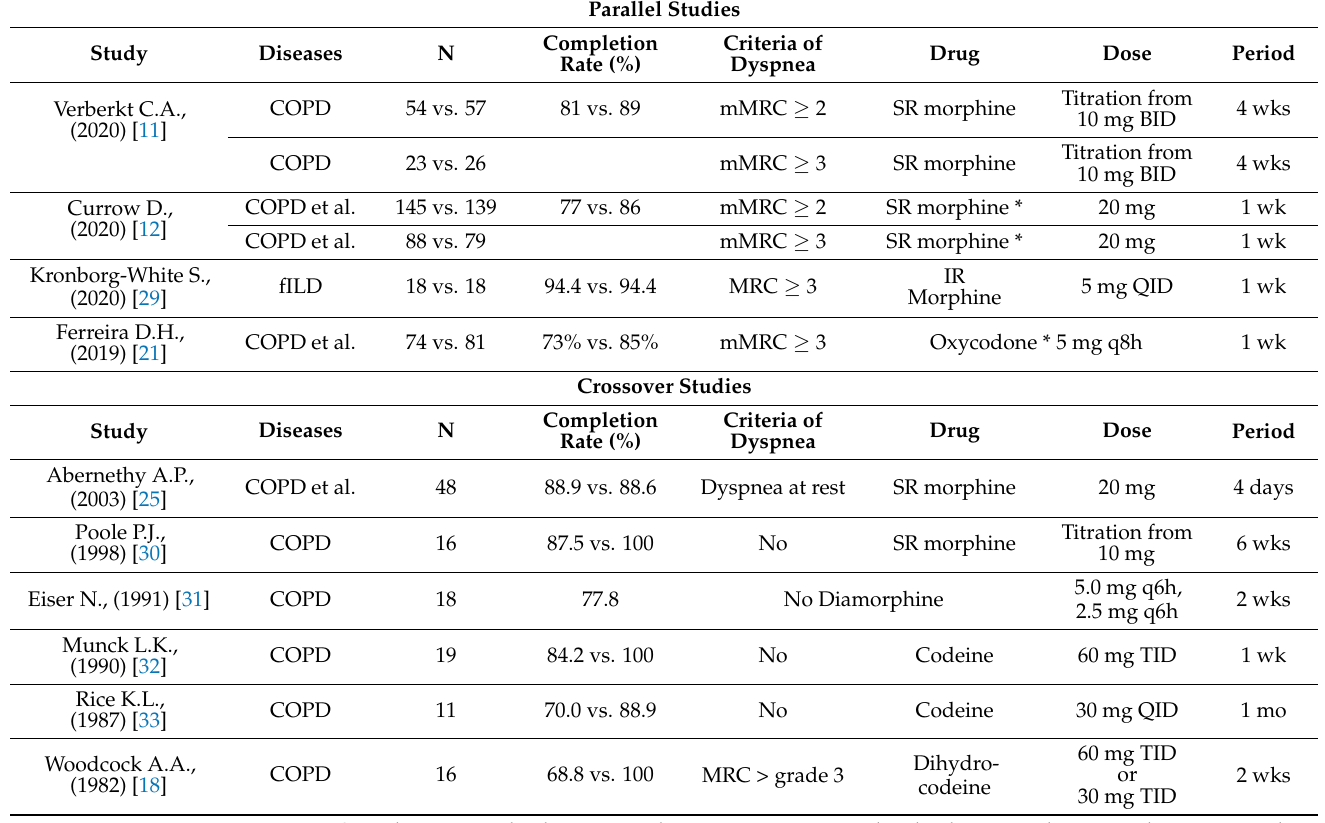
Table 1. Characteristics of randomized controlled studies regarding regularly used systemic opioids for non-cancer chronic respiratory